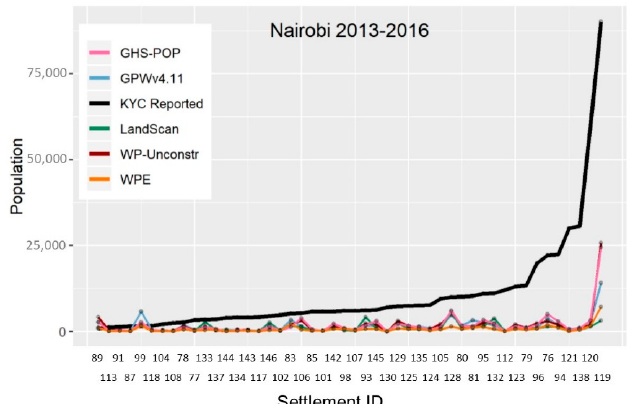
Figure A4. Full graph of gridded population estimates versus KYC reported populations in Nairobi slum settlements 2013–2016. Table A1. Reported versus digitized boundary area for settlements in which area was reported.